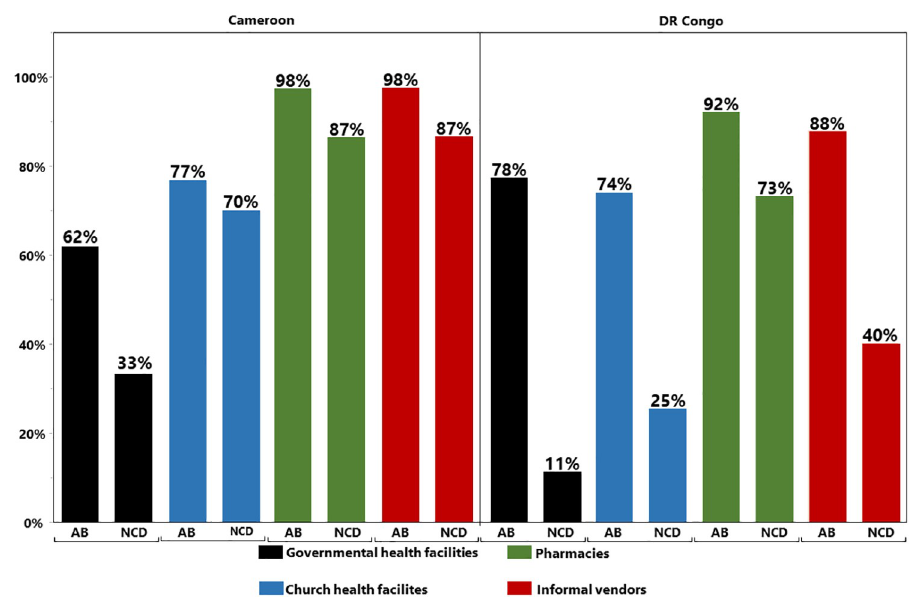
Fig 2. Availability of antibiotics and of medicines against non-communicable diseases in the four different types of health facilities.